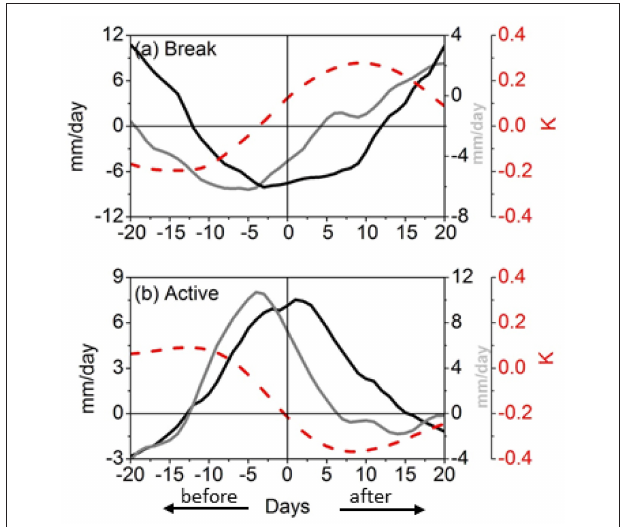
FIGURE 7 | Time evolution of composite SST anomalies (red dashed line) and precipitation anomalies over NCEN (black solid line) and BoB (gray solid line) during extended break (a) and active (b) phases form CFSv2 model simulations. Y-axis with gray and red color denotes the precipitation anomalies and SST anomalies over BoB respectively. Day “0” in the figure represents maximum in precipitation anomalies over NCEN.